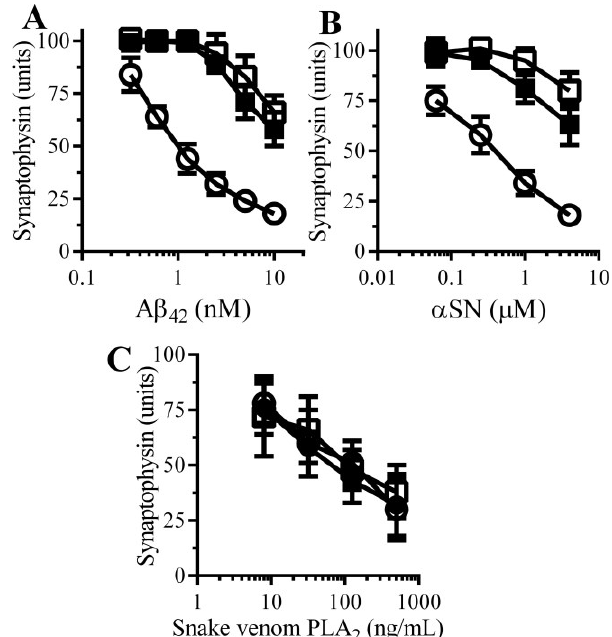
Figure 5. cAMP protects neurons against Aβ and αSN-induced synapse damage: The amounts of synaptophysin in neurons pre-treated with control medium (○), 100 µM dibutyryl cAMP (□) or 100 µM 8-bromo-cAMP (■) and incubated with Aβ 42 ( A ); αSN ( B ) or snake venom PLA 2 ( C ) as shown. Values are means ± SD from triplicate experiments performed 3 times ( n =